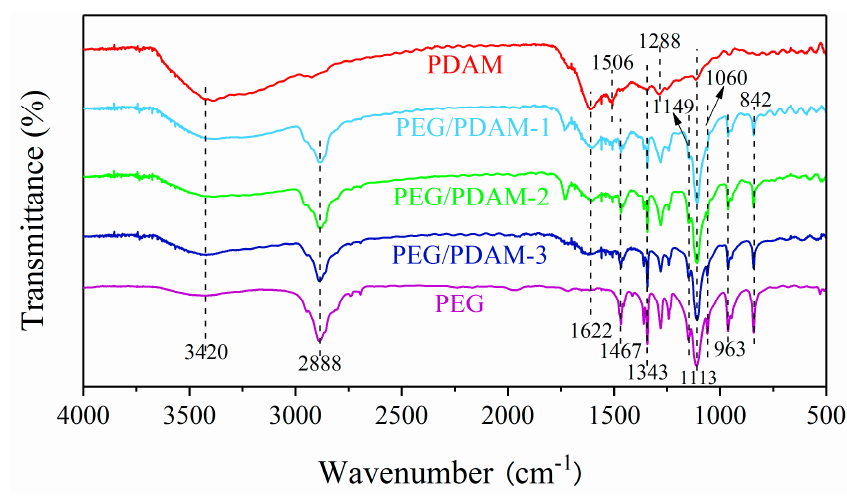
Figure 6. FTIR spectra of PEG, PEG/PDAM-1, PEG/PDAM-2, PEG/PDAM-3, and PDAM.